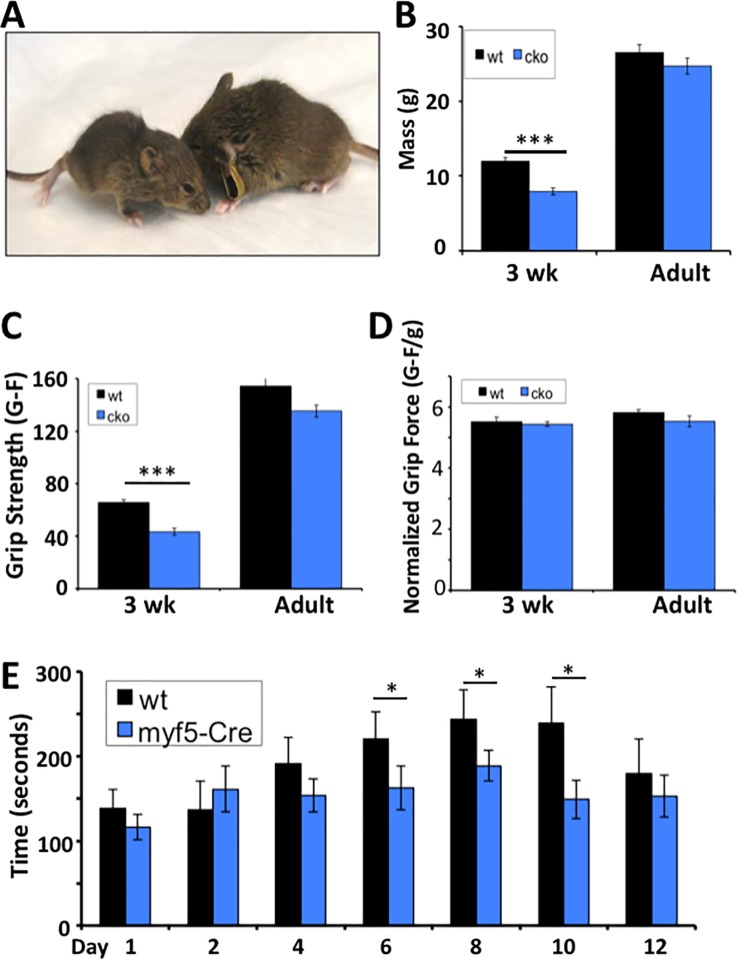
Characterization of Atrx cKO mice.(A, B) Body mass of Atrx cKO mice compared to littermate controls at 3 weeks (n = 11, 9; WT, cKO) and 8–9 weeks (n = 8, 11; WT, cKO) of age (mean ± SEM; ***p<0.001 by student’s t-test) (C) Grip strength analysis of Atrx cKO mice vs. littermate controls at 3 weeks and 8–9 weeks (adult) of age. (mean ± SEM; ***p<0.001 by student’s t-test) (D) Grip strength of Atrx cKO mice normalized to body weight. (mean ± SEM) (E) Rotorod latency time of Atrx cKO mice and littermate controls. Animals were subjected to the roto-rod apparatus for two consecutive days, and then every two days afterwards until day 12. Five trials were timed and recorded for each mouse at each experimental time point. (n = 8; mean ± 95% CI; *p<0.05 by ANOVA repeated measures statistical analysis).